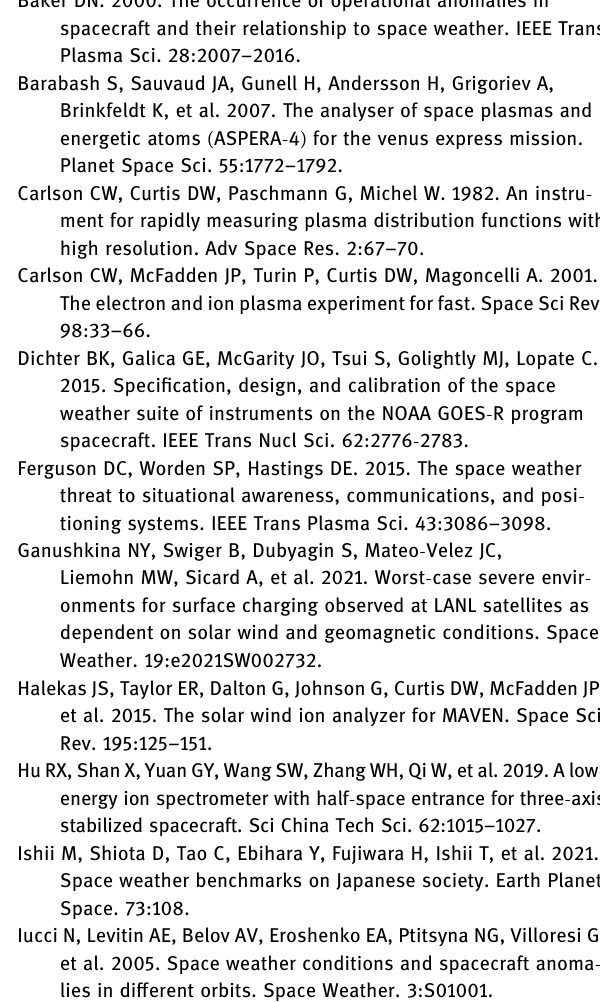
Figure 9: Di ff erential energy fl ux of ions measured by Ch05 during ( a ) 2021 - 09 - 24 to 2021 - 10 - 03 and ( b ) 2021 - 09 - 30 to 2021 - 10 -